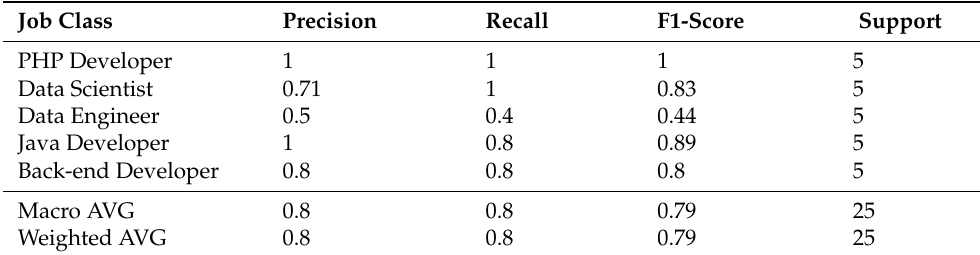
Table 6. Validating the bi-directional recommendation using decision support